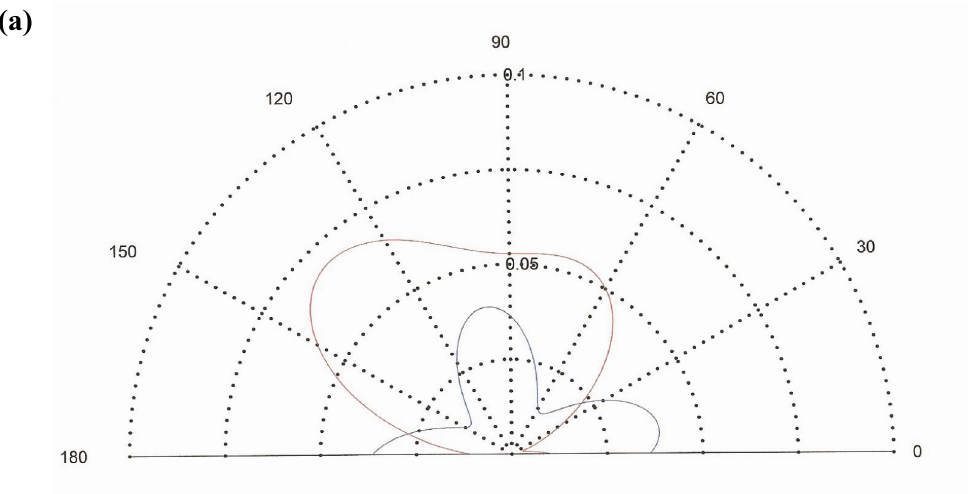
Figure 3 . Polar plots of 1/3 skew ness and kurtosis for meridians 0 to 180º for Subject 1 for the autokeratometer with ( a ) and without ( b ) two outliers are indicated. The polar plot for the sample for the Pentacam ( c ) is also provided. Solid f ) and blue (= f ). Dashed lines represent kurtosis where red (= lines represent skewness where red (= 11 21 f ). Normal distributions have a skewness of 0 and a 1 blue (= kurtosis of 1. Once the outliers were removed the 21 3 data was more normally distributed (compare ( a ) and ( b )). Figures 3( b ) and 3( c ) indicate that the samples for both instruments were relatively normally distributed once outliers were